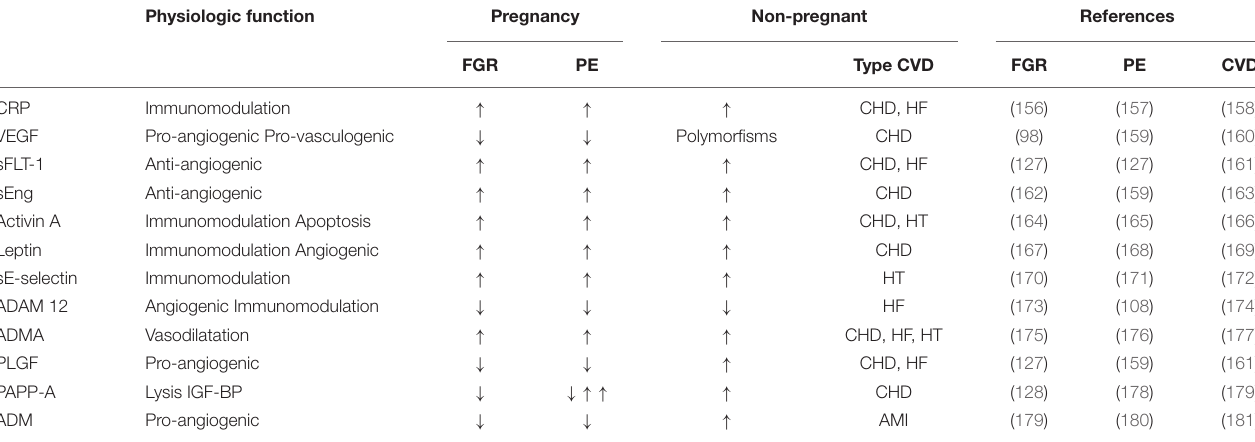
TABLE 1 | Serum markers of fetal growth restriction (FGR), preeclampsia (PET), and/or cardiovascular disease (CVD). Physiologic function Pregnancy